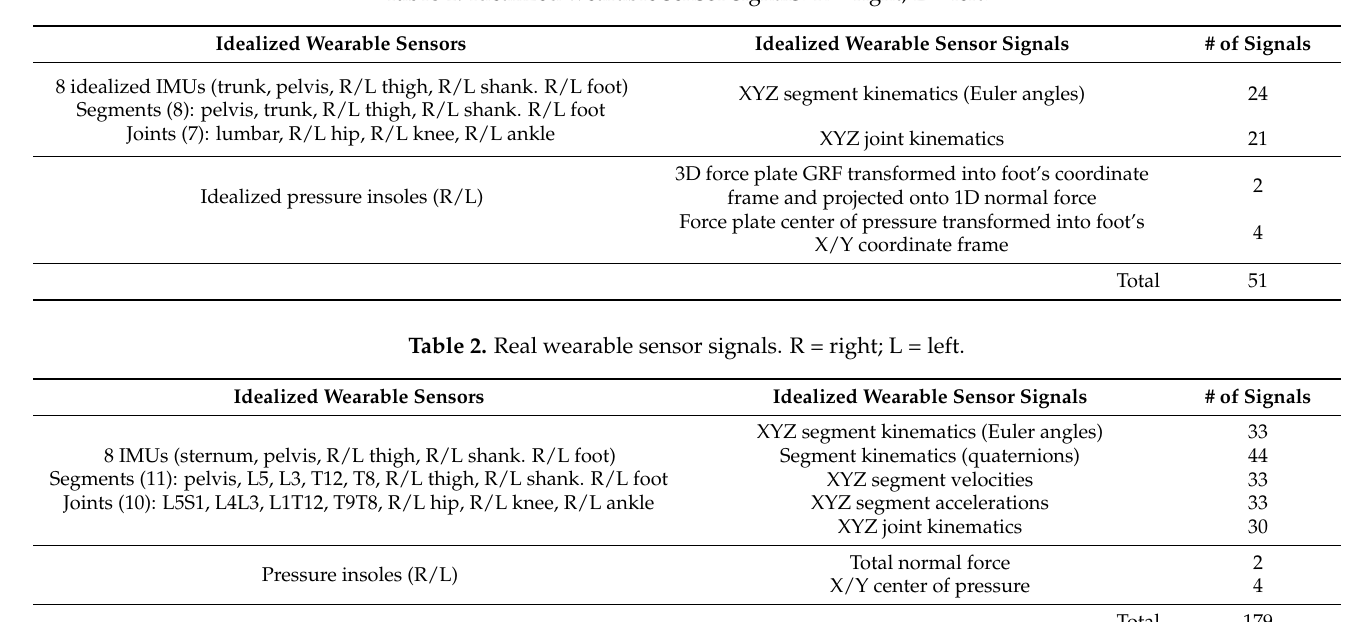
Table 1. Idealized wearable sensor signals. R = right; L = left.